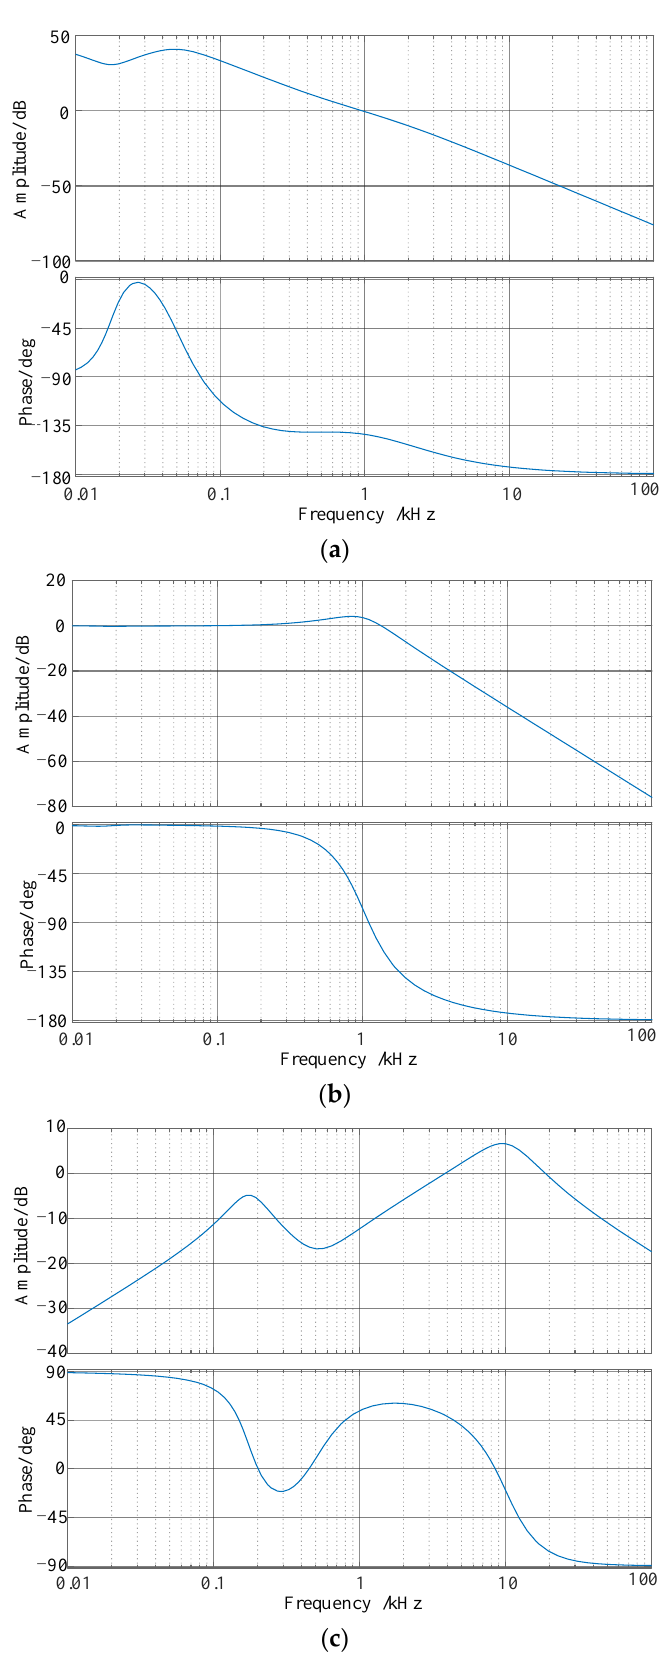
Figure 15. The bode plots the fundamental frequency is less than 60 Hz. ( a ) G i_ol ( s ); ( b ) G i_cl ( s ); and ( c ) G u_i ( s ).